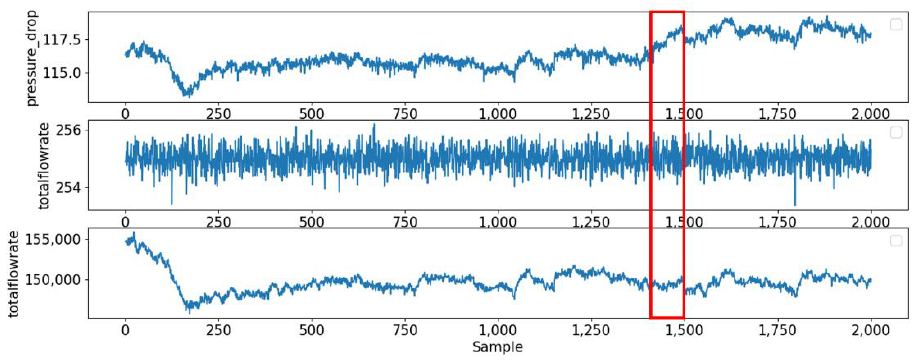
Figure 12. Variation trend of pressure drop at hot end.